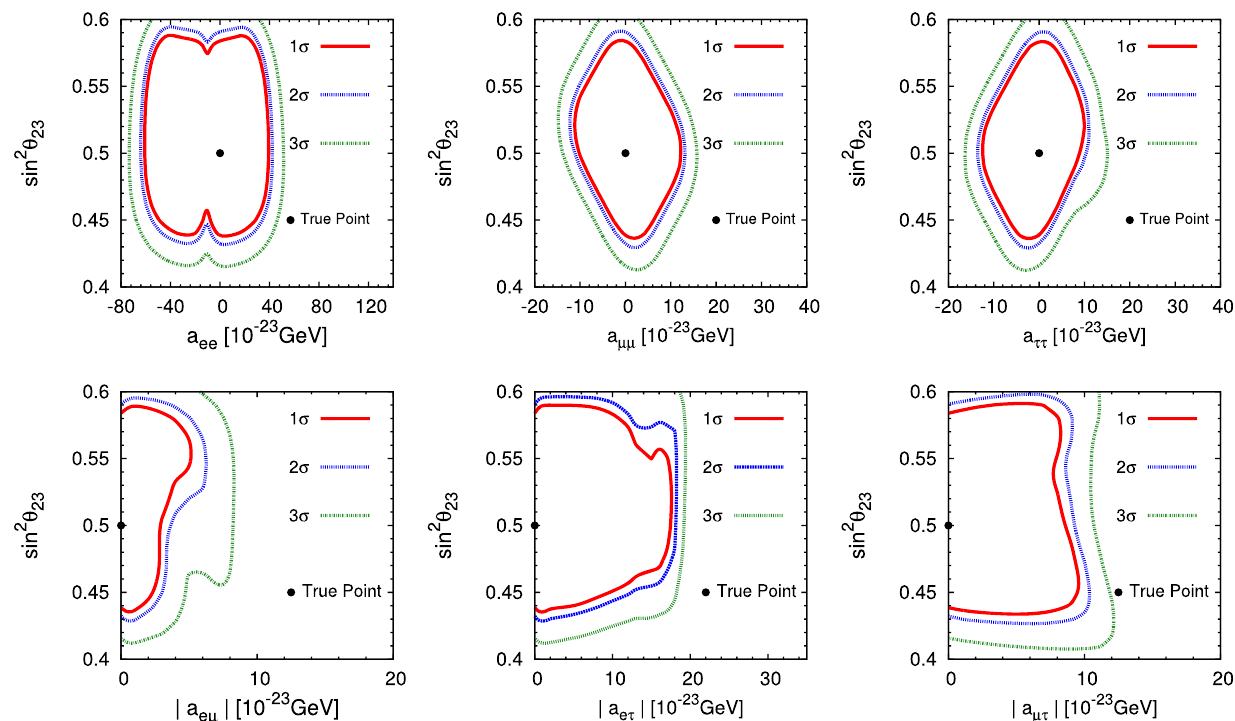
Fig. 9 Correlation between LIV parameters and θ 23 in | a αβ | − sin 2 θ 23 plane at 1 σ , 2 σ and 3 σ C.L. for NO ν A experiment